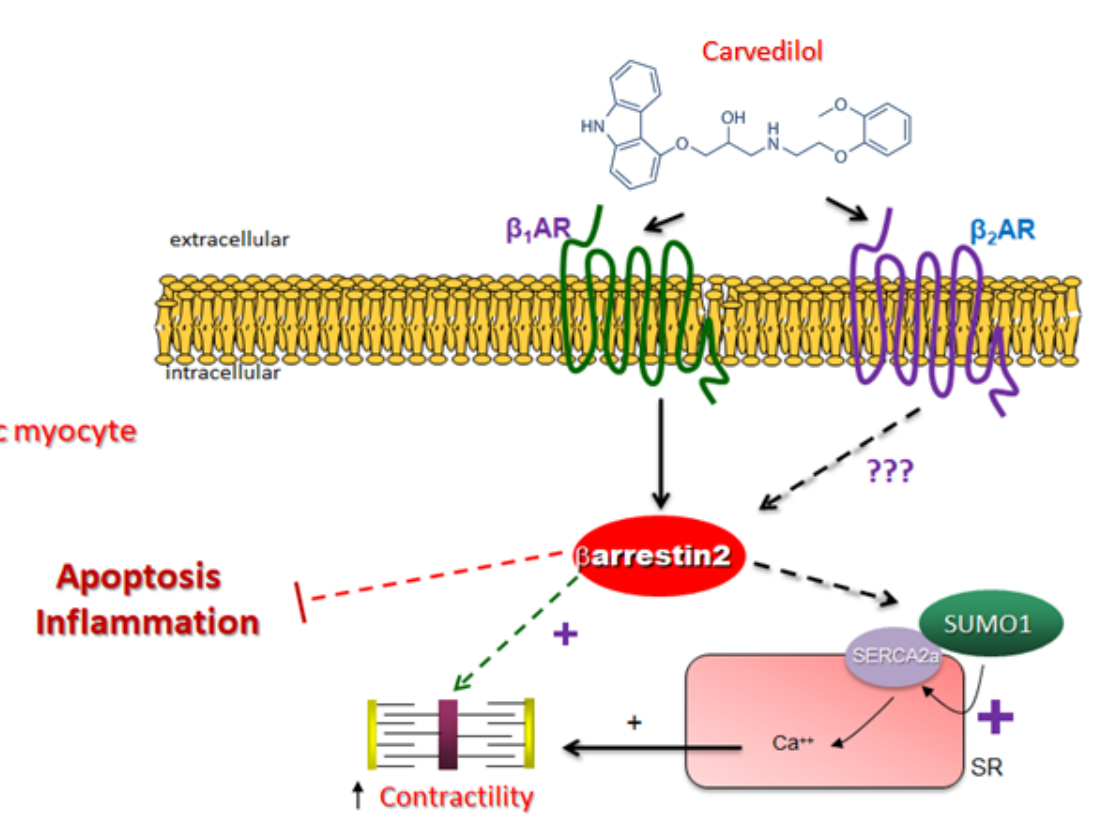
Figure 5. Schematic illustration of carvedilol’s positive inotropic effect via stimulation of the β 1 AR- βarrestin2 -SERCA2a SUMOylation axis in cardiac myocytes. See text for details. SR: Sarcoplasmic reticulum; SUMO1: Small ubiquitin-like modifier-1; ???: Effect/signaling pathway